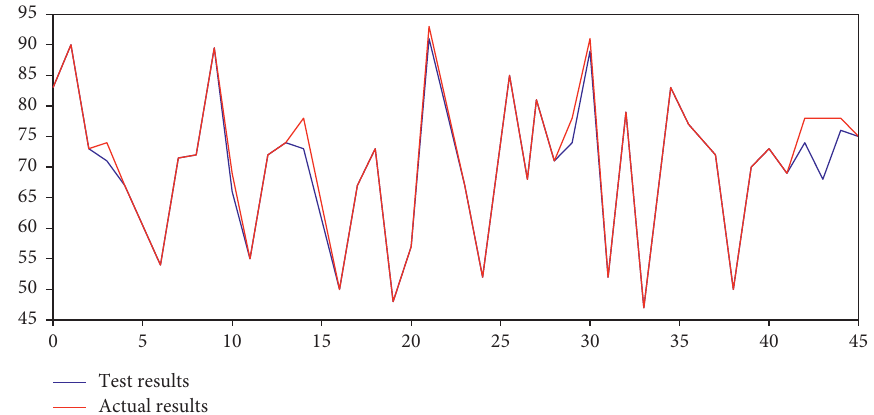
Figure 7: The comparison of the forecast data with the actual film data.